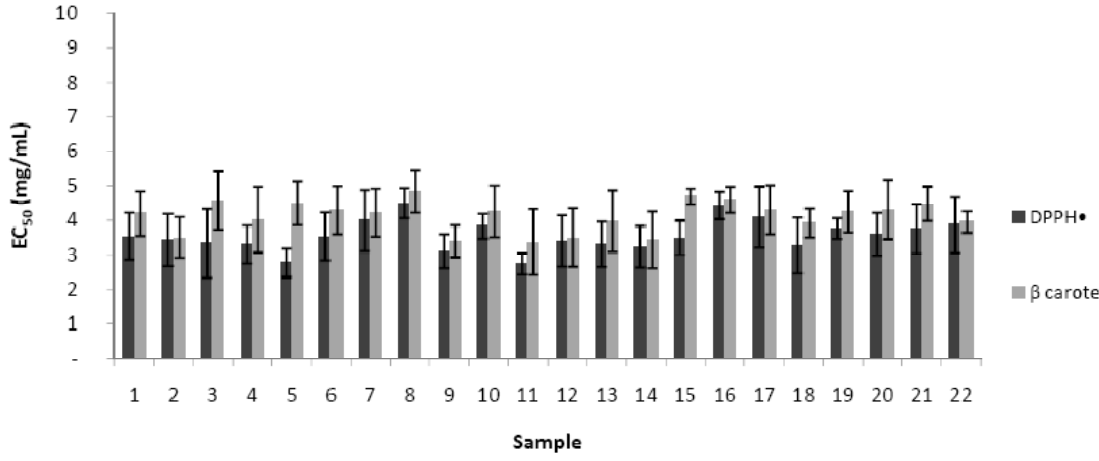
Figure 2. EC values (mg/mL) obtained for the antioxidant activity by scavenging of 50 2,2-diphenyl-1-picryl-hydrazyl radicals (DPPH) and β -carotene bleaching assay (BCB) in the extracts from organic apian pollen